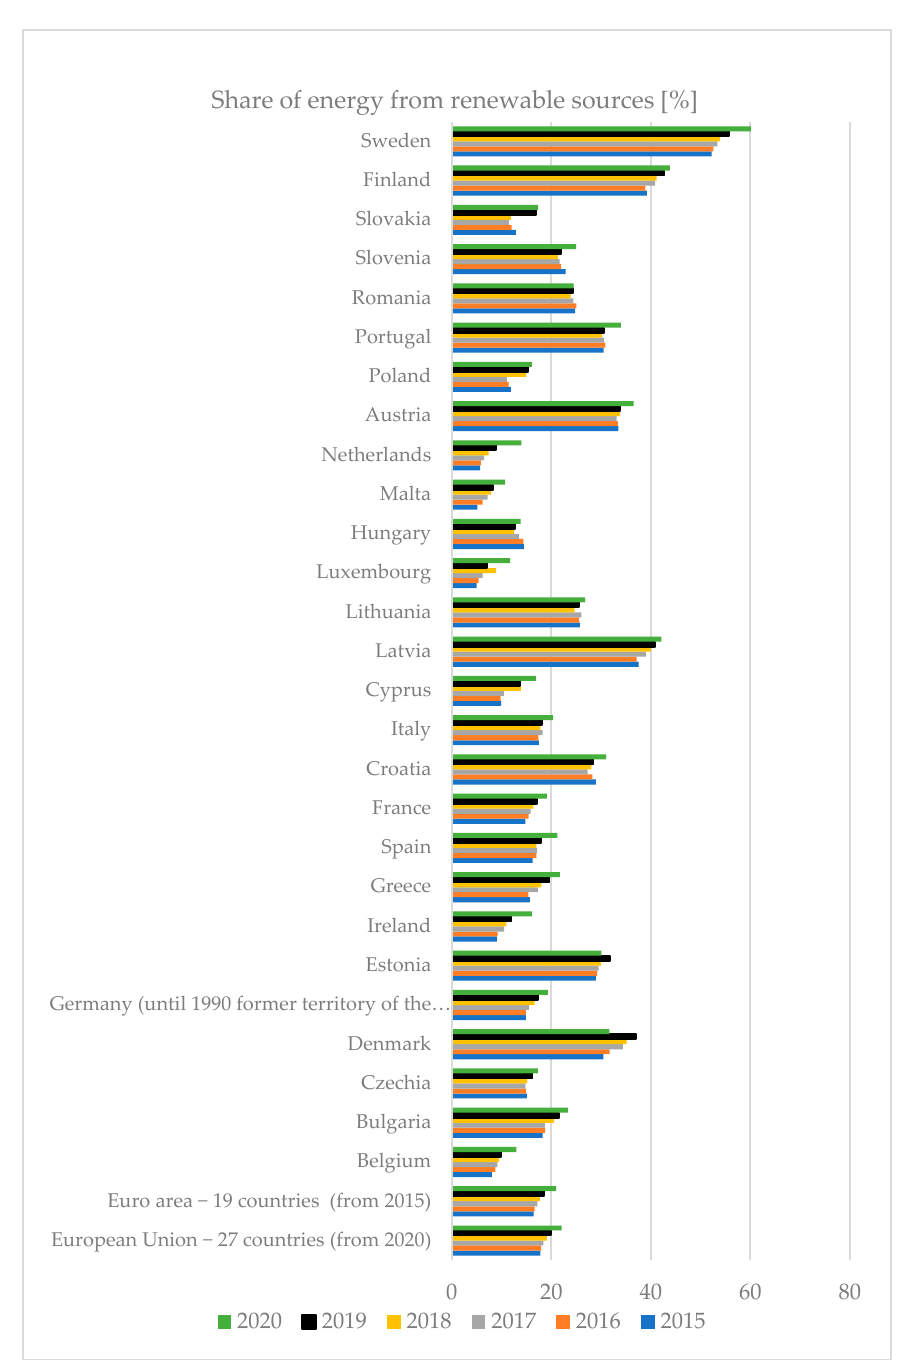
Figure 1. The percentage share of renewable energy in individual EU member-states between 2015 and 2020. Source: Authors’ original compilation based on the Eurostat data [84].